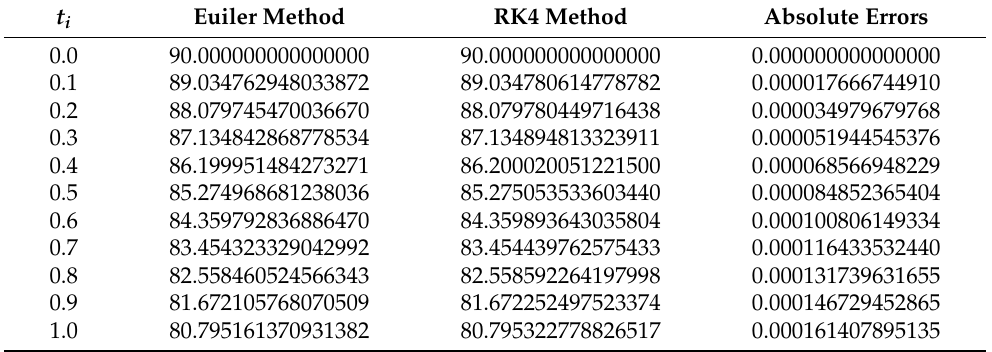
Table 6. Comparison between the results of the modified Euler method and RK4 method for S ( t ) .